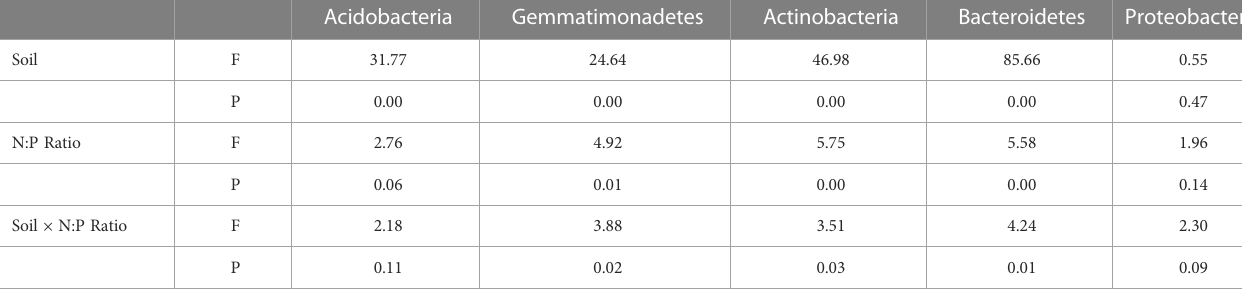
TABLE 4 Two-way ANOVA of dominant bacterial phyla of bacterial community. Acidobacteria Gemmatimonadetes Actinobacteria Bacteroidetes Proteobacteria